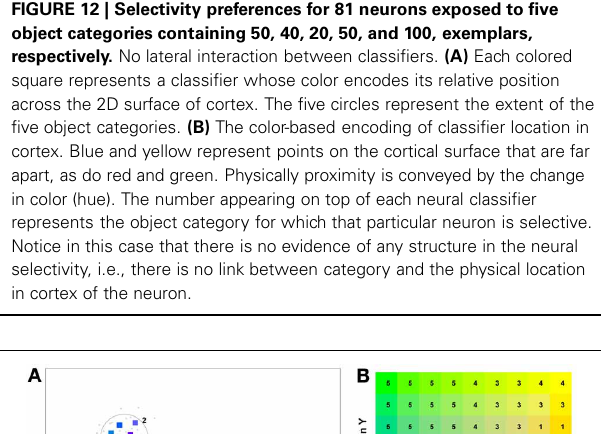
FIGURE 11 | The stability of the network response to face stimuli undergoing two types of image manipulation. The “exchange” condition corresponds to the replacement of the lower half of a face with that of another person. The “delete” condition corresponds to the blanking of the lower half of the image. The vertical axis provides a measure of the overlap in neural output activity between the control condition of the original stimulus being presented and the particular manipulation, such that 1 indicates that exactly the same “n” neurons were most active after manipulation of the image as were most active before. Analysis of just the most active neuron is labeled “1”, the two most active neurons labeled “2”, and so on up to the five. As one might expect, deletion is seen to produce smaller changes in the output code from the control condition than exchanging the lower half of the face with another. Significantly, the impact of both manipulations is much more marked for the same race faces than for the other race faces (output similarity drops well below 1.0).